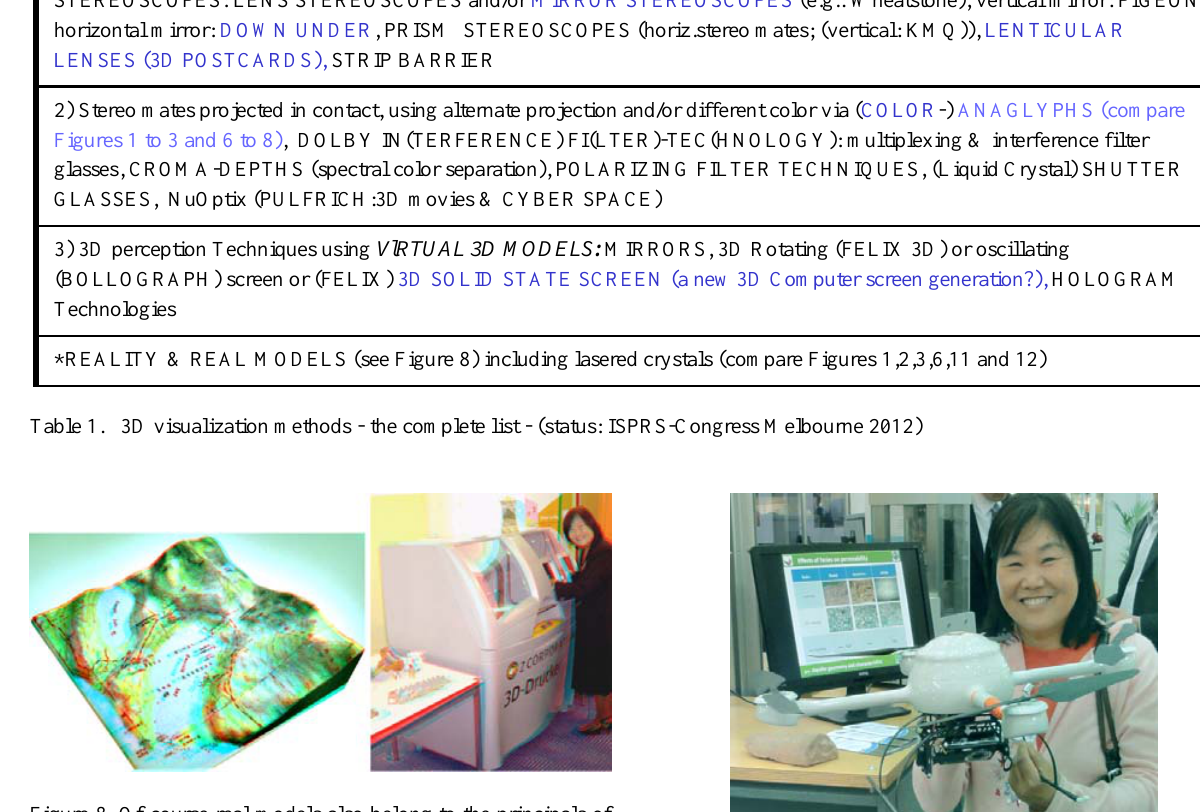
Figure 8. Of course real models also belong to the principals of 3D visualization, like here a terrain model, as carried out, by a 3D printer (courtesy Comp. KISTERS (Germany); 3D